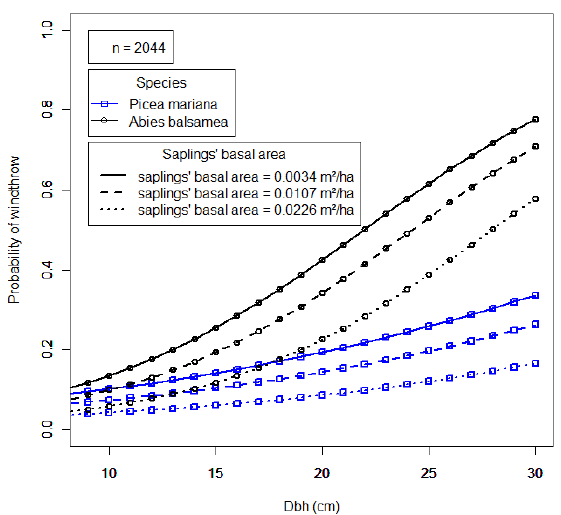
Figure 1. Probability of windthrow for group retention on mesic shallow tills of eastern Quebec (From Lavoie et al. [28]).